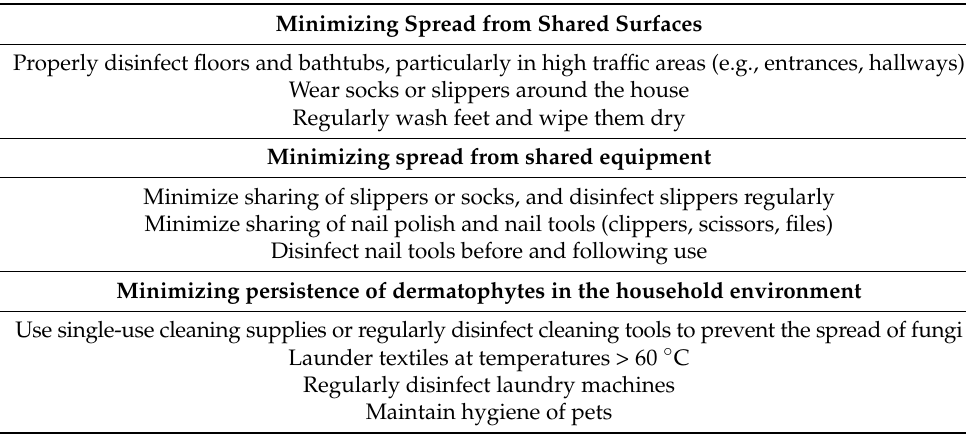
Table 2. Recommendations to limit the household spread of